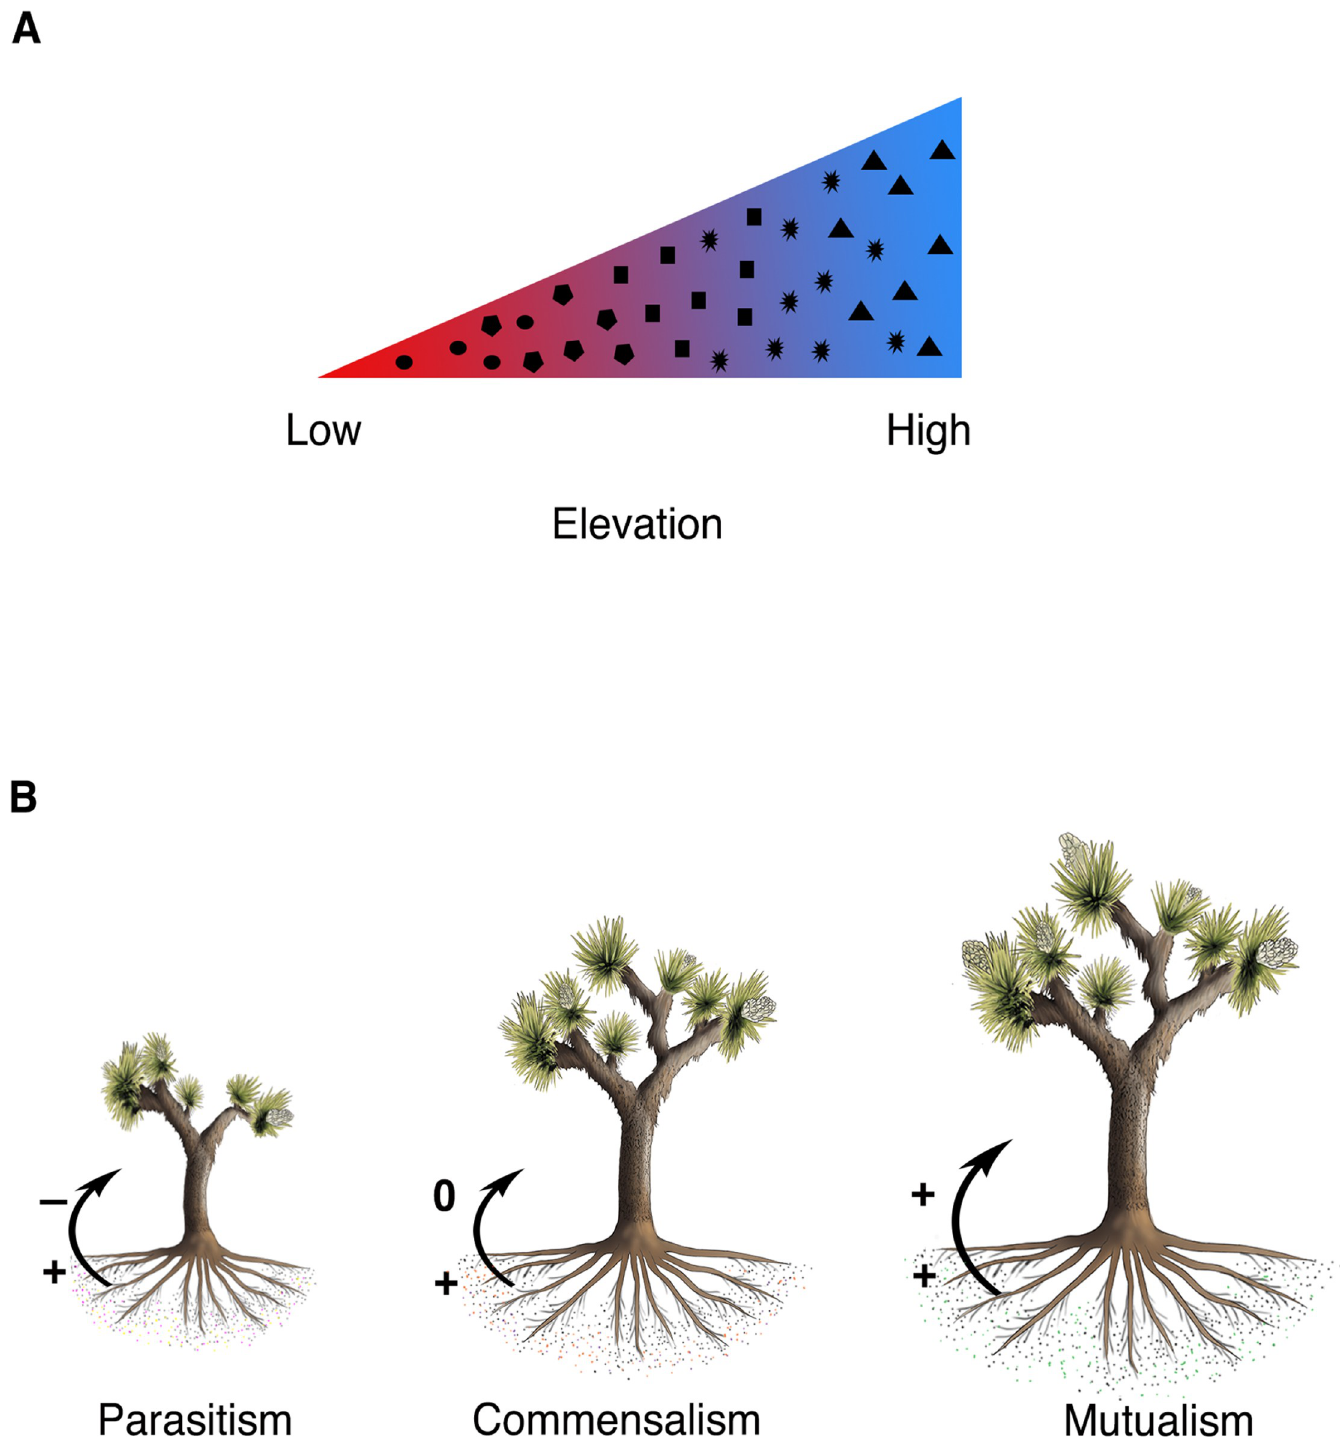
Fig 1. Abiotic and biotic effects on plant-AMF mutualistic outcomes when inoculated with fungi from an elevation gradient. A) Abiotic effects: AMF community composition in Joshua tree roots changes along an elevation gradient. Elevation gradient in the figure corresponds to a changing climate gradient with warmer temperatures at the lowest elevations and the coolest temperatures at high elevations. Changes in fungal communities are represented by the assorted changing black shapes. B) Biotic effects: Variation in the AMF community correspond to different symbiotic outcomes for Joshua trees. Outcomes can range from positive to negative with the arrow demonstrating fungal parasitism (+, -) of the tree, commensalism (+, 0) with the fungus benefitting but not damaging the tree, or mutualism (+, +) with both the tree and the fungi benefitting.